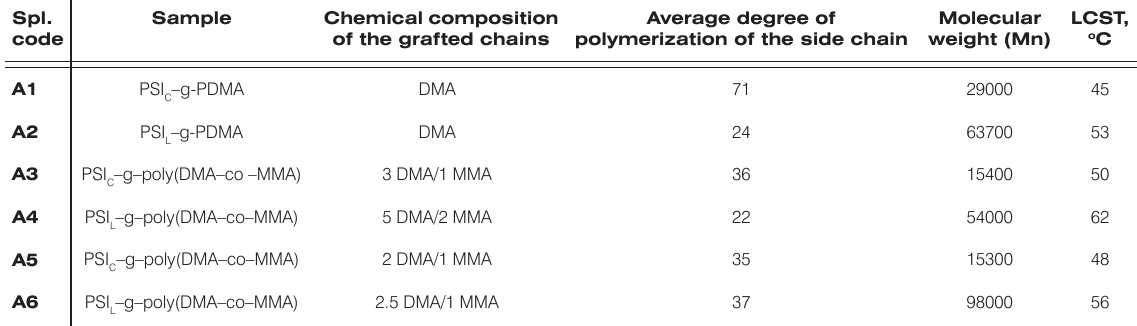
Table 1. Characteristics of different graft polysiloxanes. Spl.